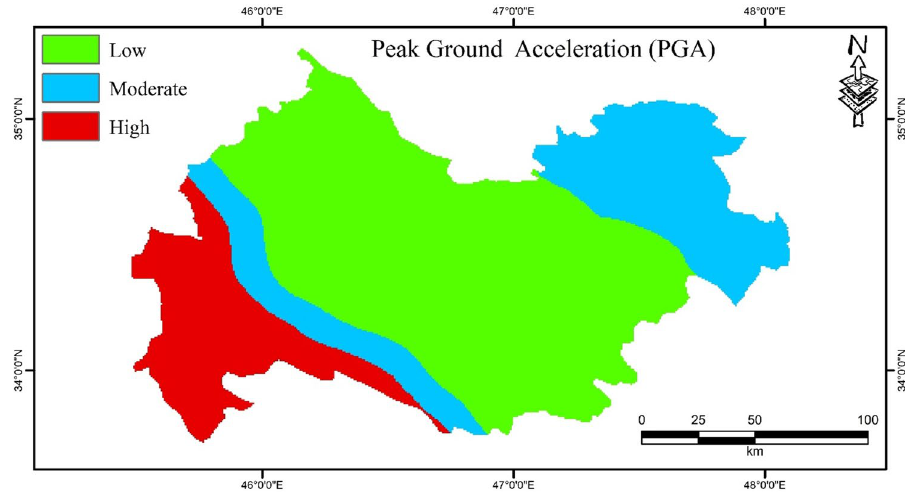
Figure 4. PGA map for the Kermanshah province using ArcGIS 10.3.1 software.